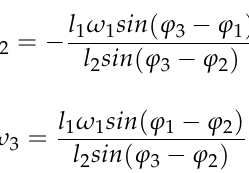
Driving rod position